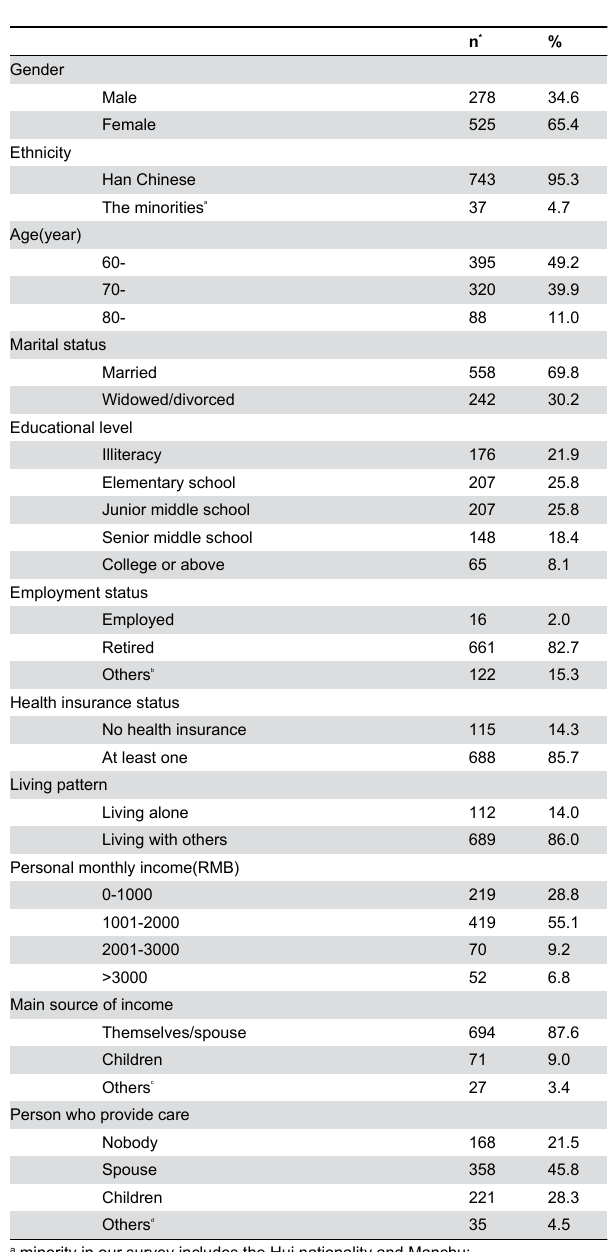
Table 1. Demographic characteristics of the 803 elderly people in Jinan,